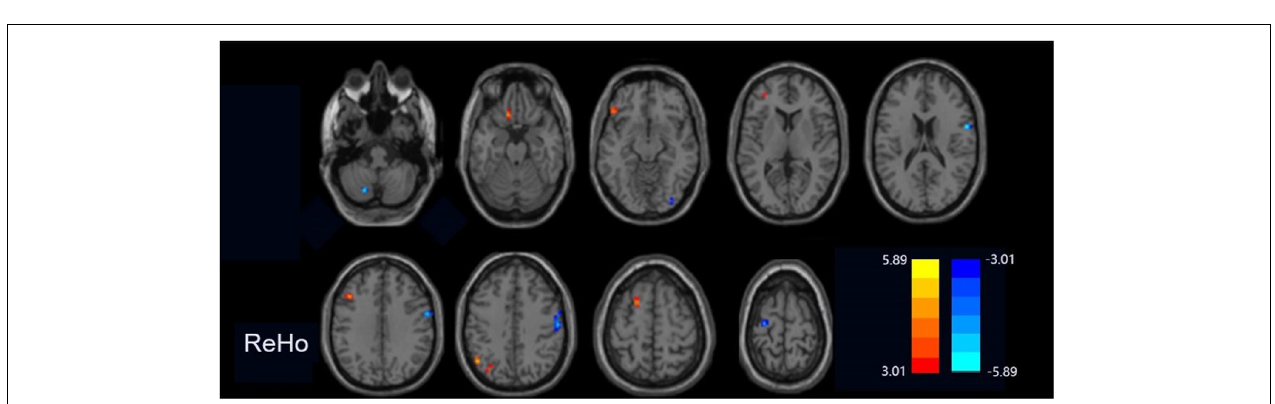
FIGURE 1 | Regions exhibiting differences in fALFF between peripartum depression and healthy postpartum women (p < 0.005 corrected by FDR). The warm colors represented the significance of higher fALEF values and the cool colors represented the significance of lower fALFF values for the group comparisons.